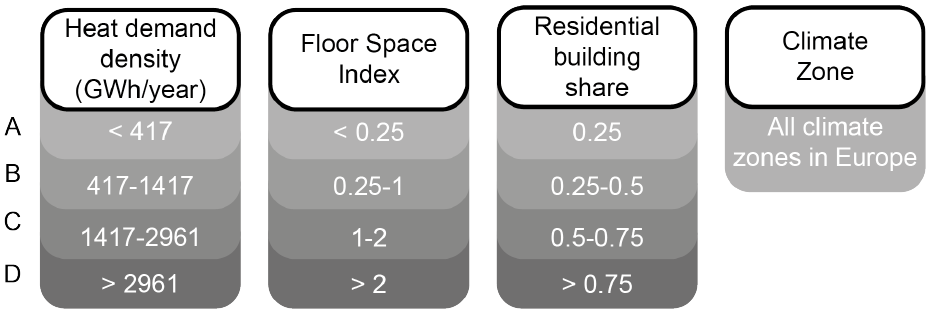
Figure 3. The district categorisation